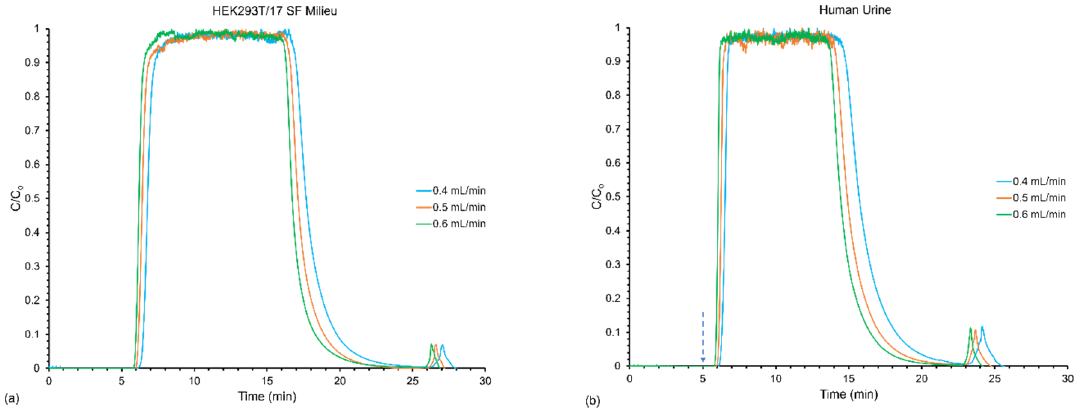
Figure 3. Frontal loading response for the effect of varying the loading and elution flow rates of the ( a ) HEK293T/17 SF milieu and ( b ) human urine samples from 0.4–0.6 mL min − 1 .